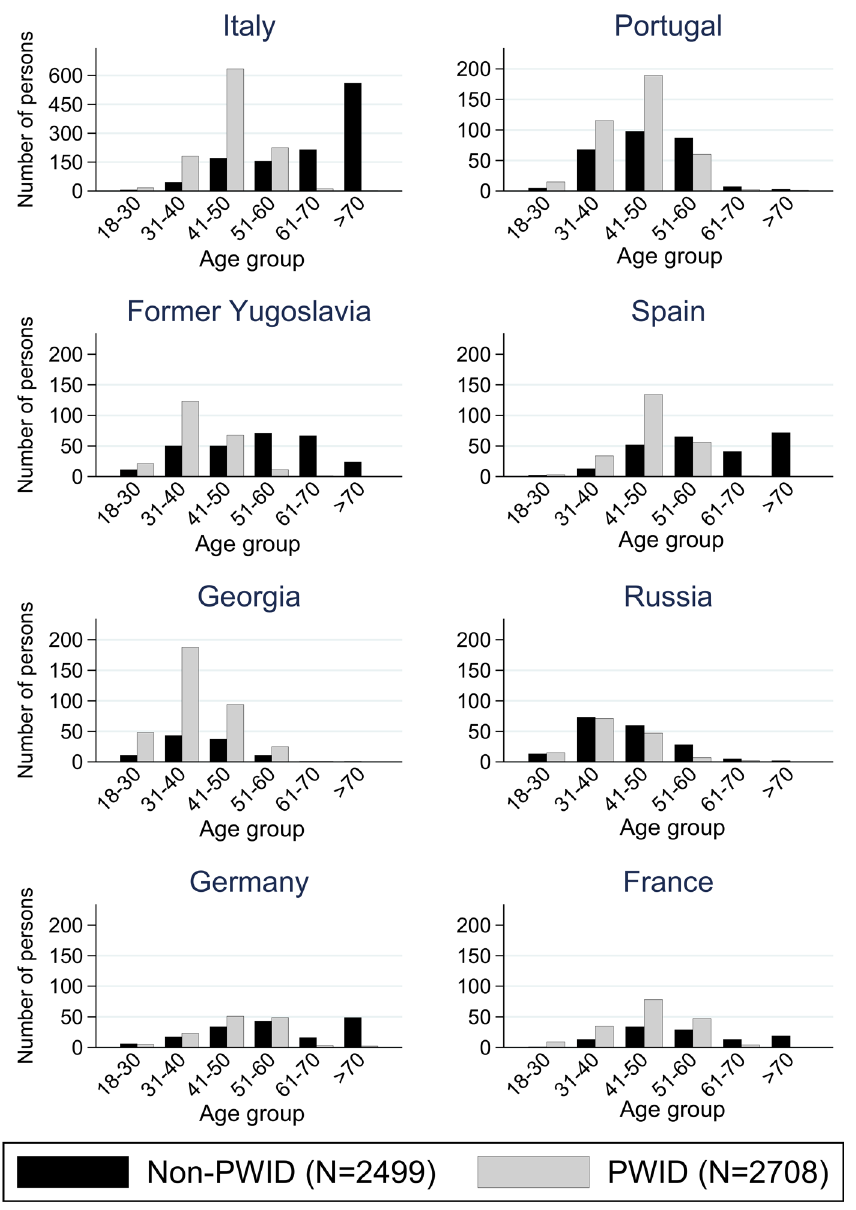
Fig 3. Persons who do not inject drugs (non-PWID) versus persons who inject drugs (PWID) among foreign-born persons in the national surveillance data of the Federal Office of Public Health, by country of origin and age (please note the different y-axis scale for